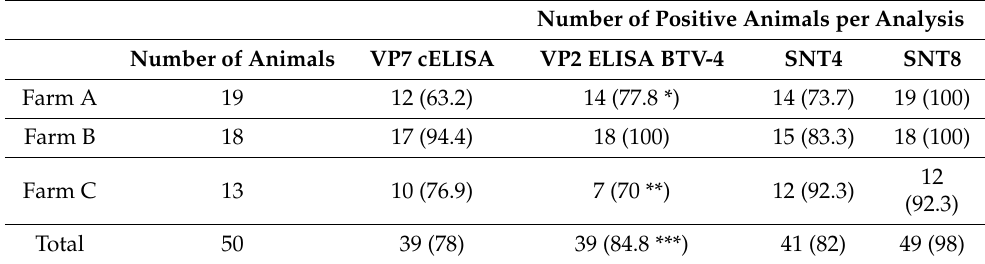
Table 2. Serological results (ELISA and SNT BTV4 and 8) from sera sampled at D0.